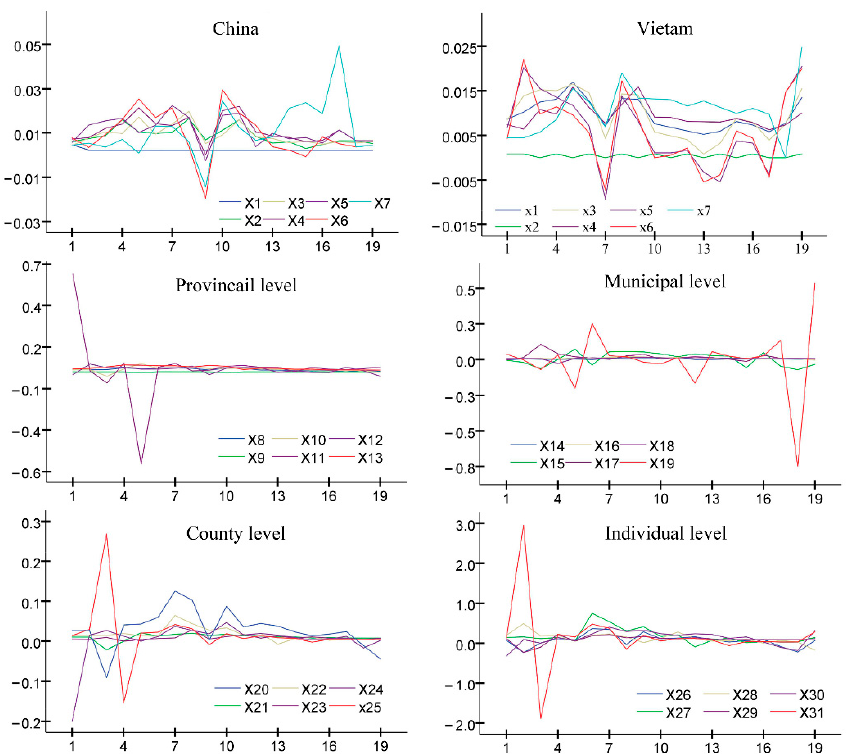
Figure 3. Impulse response function diagrams at different scales.